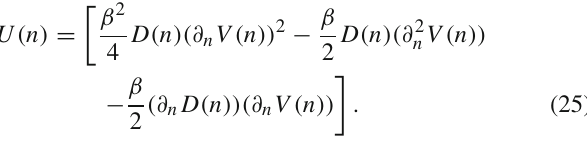
Fig. 3 Variation of probability density function for It ˆ o and Stratonovitch with the occupation number per